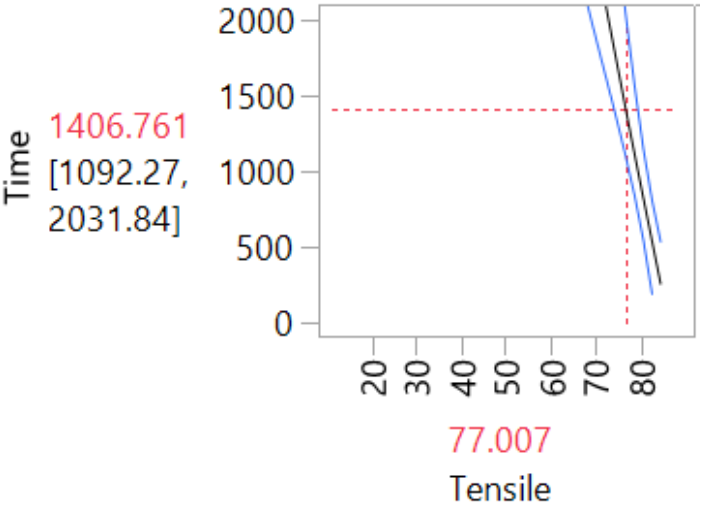
Figure 2. Intersection point in time and 10% of degradation.